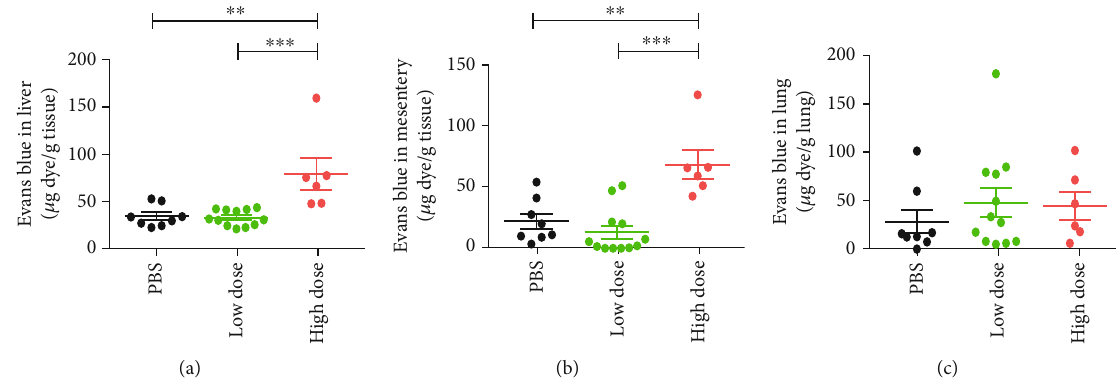
Figure 4: Administration of a high dose of HNP-1 impairs vascular permeability during sepsis progression. Wild-type mice were intraperitoneally administered a high dose of HNP-1 (10 mg/kg body weight), a low dose of HNP-1 (0.5mg/kg body weight), or PBS 6 hours after CLP. (a – c) An in vivo Evans blue dye permeability assay in the liver (a), mesentery (b), and lung (c) at 48 hours after CLP. The results shown are the means ± SEMs of 6 mice in the high-dose group, 12 mice in the low-dose group, and 8 mice in the PBS group. ∗∗ P < 0 : 01 , and ∗∗∗ P < 0 : 001 .